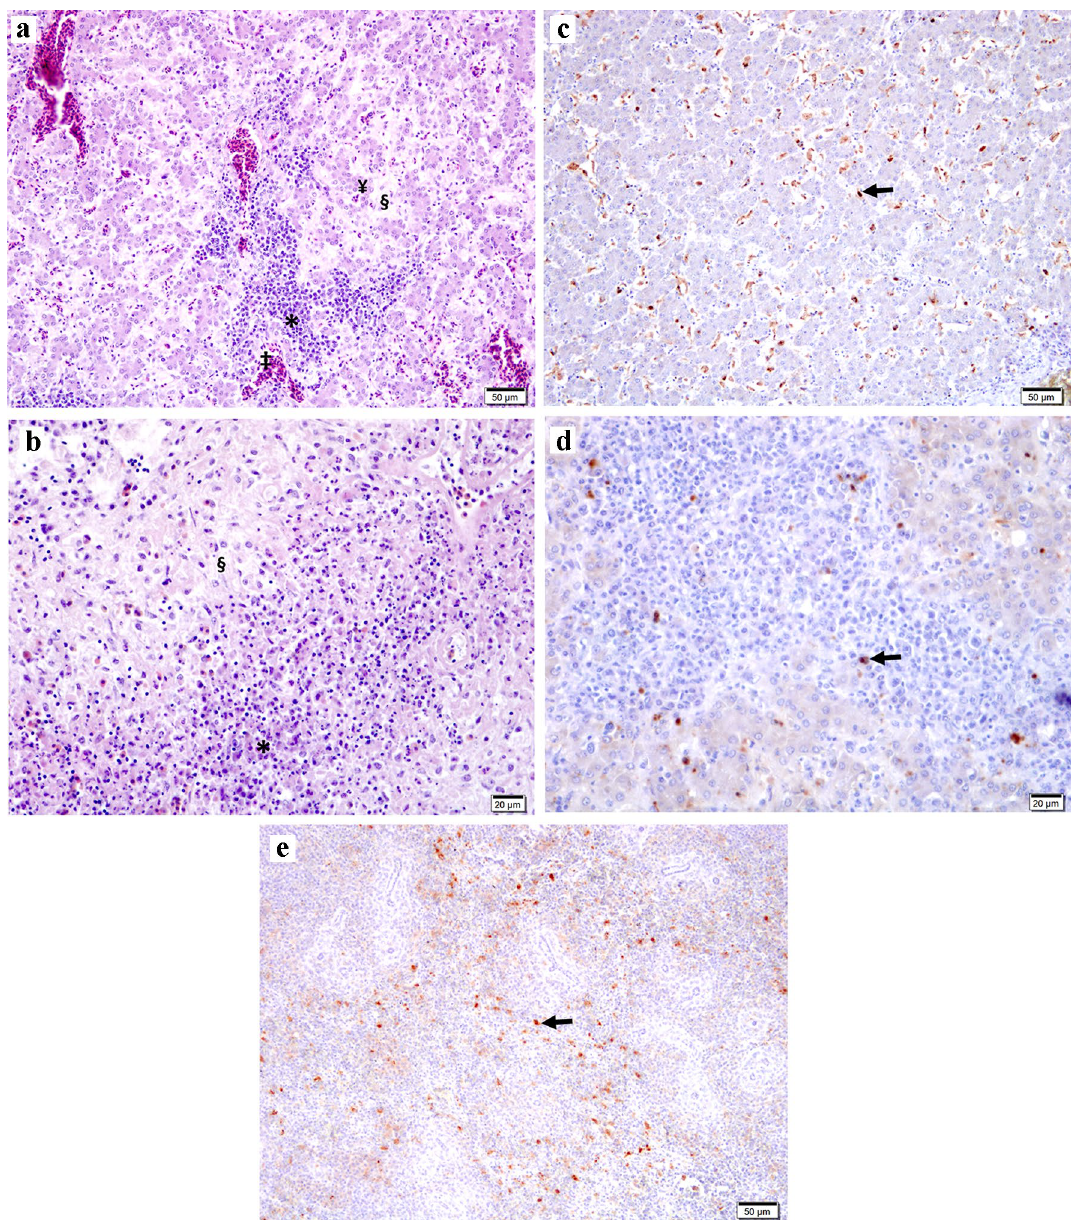
Figure 2. Histopathological and IHC investigations on samples from chickens suffering from HSS. In liver ( a ), infiltrations of heterophils and mononuclear cells can be observed (*), together with compression and atrophy of the hepatic cords and hepatocytes (¥) due to the accumulation of proteinaceous material in the sinusoids indicating amyloid (§). Sinusoidal congestion (‡) can also be noticed (H & E; bar = 50 µm). The spleen ( b ) presents lymphocytic infiltration (*), with extensive disruption of the splenic tissue by homogenous, eosinophilic material most suggestive of amyloid protein (§) (H & E; bar = 20 µm). Positive signals for the aHEV ORF2 ( → ) are shown by IHC in the sinusoids, in the liver ( c ; bar = 50 µm), and in association with areas of mononuclear cell infiltrations ( d ; bar = 20 µm), as well as in the peri-ellipsoidal zones throughout the spleen ( e ; bar = 50 ing regions, complete open reading frames ORF1, ORF2, and ORF3 were identified in their respective order in the genome, with the ORF1-translated polyprotein enclosing most amino acid substitutions among all ORF- translated proteins due to the hypervariable polyproline region (Supplementary Fig. S2). The phylogenetic analysis was based on whole genome sequences belonging to the species Orthohepevirus B . All aHEV genomes reported here clustered together in a separate branch, representing a new putative aHEV genotype (Fig. 4), with a shared nucleotide sequence identity of 98–99.3%, and a 79.7–83.3% nucleotide identity with other aHEVs (Supplementary Table S1—Percent identity complete genomes).